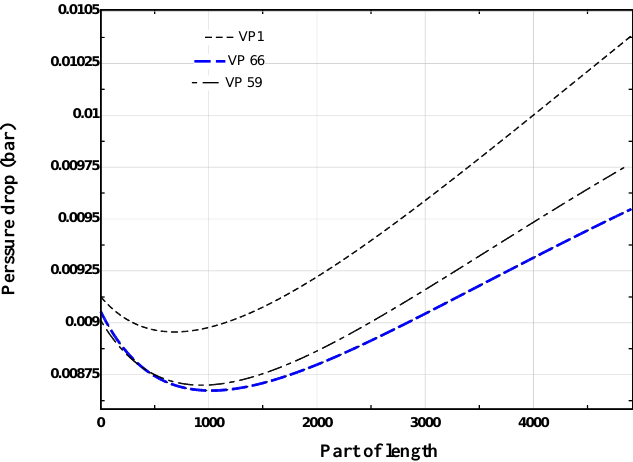
Figure 6. Pressure drop vs. pipe segments for different thermal oils